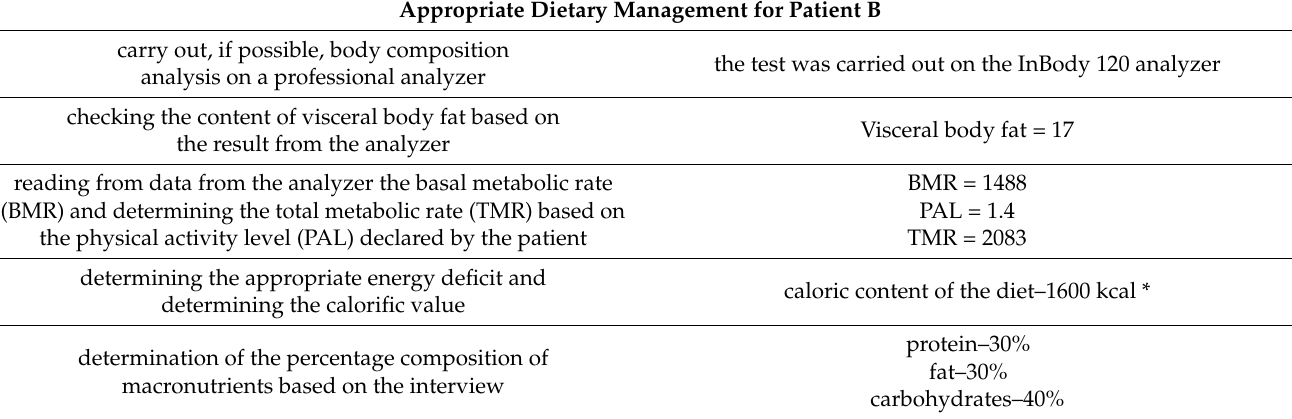
Table 8. Appropriate dietary management for Patient